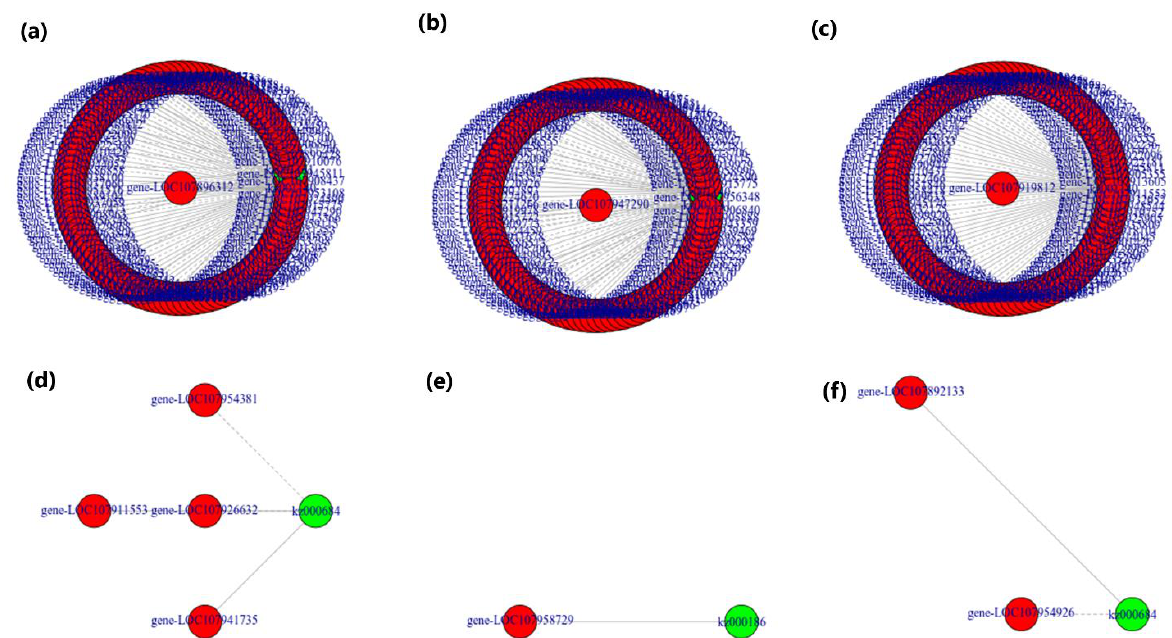
Figure 11. Correlation network diagram of DEGs and DAMs involved in the production and regula- tion of glucose-1-phosphate (G1P), uridine 5 (cid:48) -diphospho-D-glucose (UDP-G1c), and 2-deoxyribose 1-phosphate (dR-1-P) of cotton seedlings in the CK group and seedling samples that were NaCl- pre-treated for 0.5, 1, and 1.5 h, illustrating the KEGG pathway enrichment of DEGs and DAMs viz. ( a ) CK-vs.-N0.5, ( b ) CK-vs.-N1, ( c ) CK-vs.-1.5, ( d ) N0.1-vs.-N1, ( e ) N0.5-vs.-N1.5, and ( f ) N1-vs.-N1.5. Green circles represent DAMs. In contrast, s represents DEGs, while the connecting lines represent their correlations, with solid ones for positive correlations and dotted ones for negative